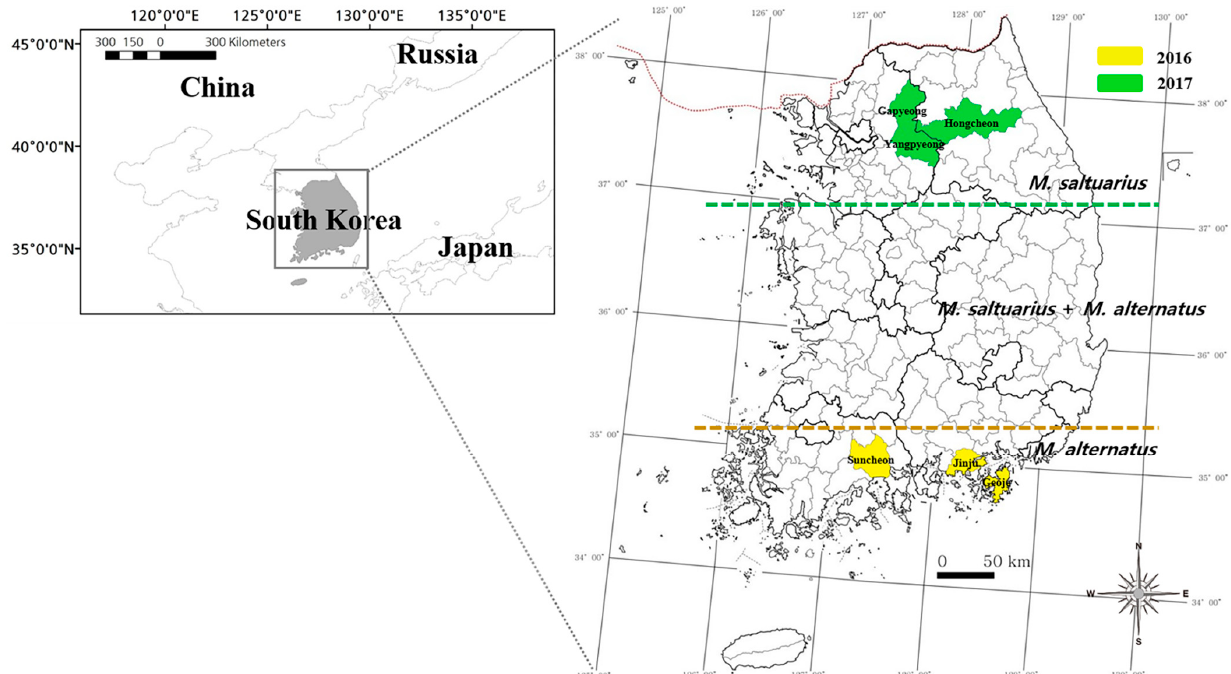
Figure 1. Parasitoid survey sites in South Korea in 2016 (yellow; Suncheon, Jinju, and Geoje) and 2017 (green; Gapyeong, Yangpyeong, and Hongcheon).